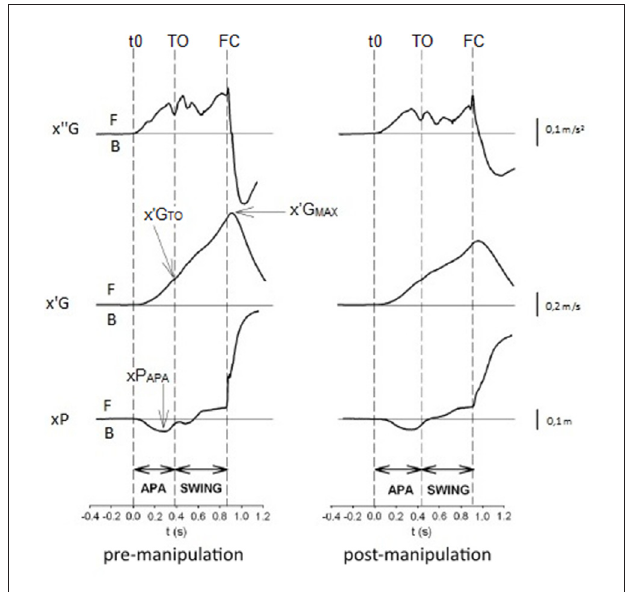
FIGURE 4 | Biomechanical profiles of gait initiation in the pre- and post-manipulation conditions in one representative participant of the HVLA group. x (cid:48)(cid:48) G, x (cid:48) G, xP: anteroposterior center of gravity (COG) acceleration, COG velocity, and center of pressure (COP) displacement, respectively. t0, TOT, foot-contact (FC): onset rise of x (cid:48)(cid:48) G trace, swing toe-off (TO) and swing FC. Anticipatory postural adjustments (APA), SWING: APA and swing phase. x (cid:48) G MAX , x (cid:48) G TOT , xP APA : peak of COG velocity, COG velocity at TO, peak of anticipatory backward COP displacement. F: forward displacement, velocity or acceleration, B: backward displacement, velocity or